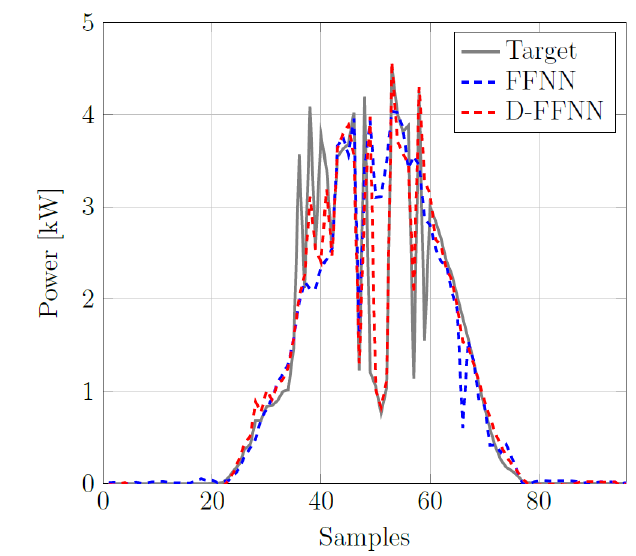
Figure 18. Prediction of a variable day, having an irregular shape, 4 April 2019: the continuous line indicates the real measurements and the discontinuous line refers to the D-FFNN predicted values.